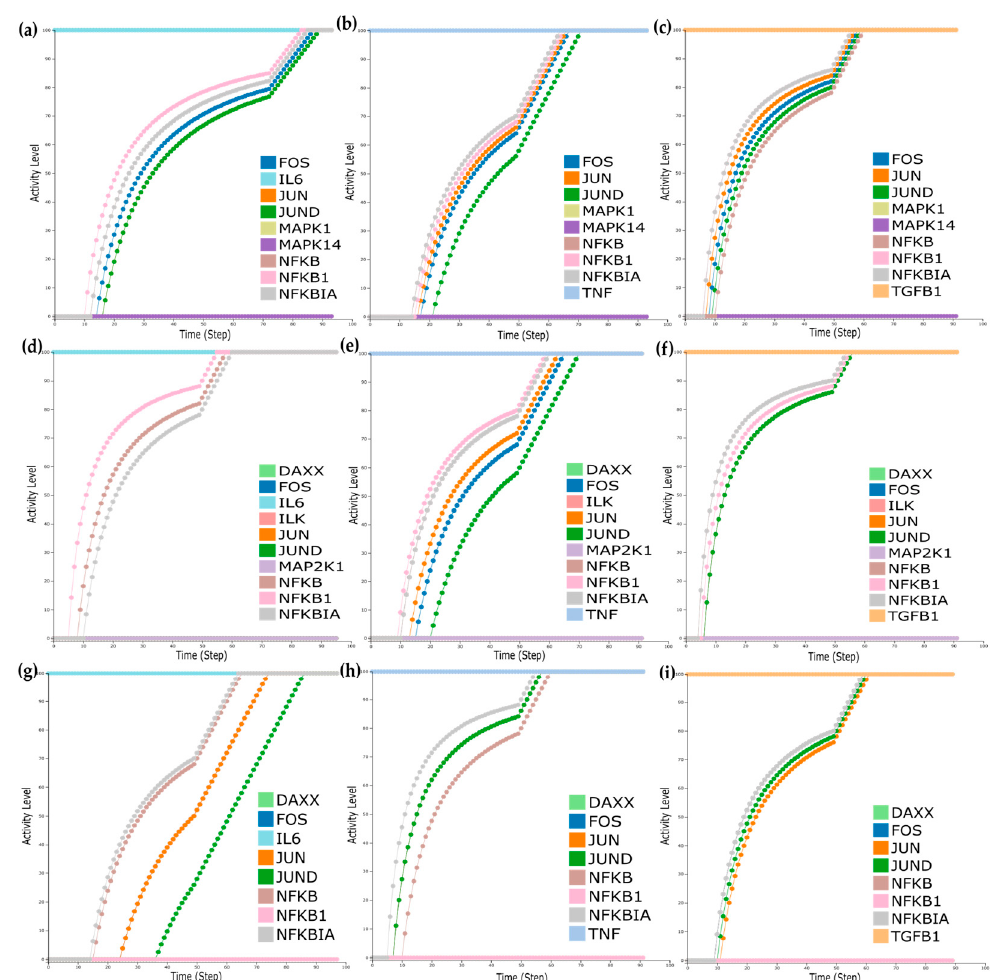
Figure 6. Real-time simulations with Cell Collective for the dataset of before and after anti-TNF treatment of RA patients, where MAPK14 and MAPK1 were found to be downregulated ( a – c ); ( a ) simulations with IL6 activity set to 100%, ( b ) simulations with TNF activity set to 100%, ( c ) simulations with TGFB1 activity set to 100%. Real-time simulations for the dataset of responders/non-responders where MAP2K1, ILK, and DAXX were found downregulated ( d – f ); ( d ) simulations with IL6 activity set to 100%, ( e ) simulations with TNF activity set to 100%, ( f ) simulations with TGFB1 activity set to 100%. Real-time simulations for the dataset of the mutation carrier. ( g – i ); ( g ) simulations with IL6 activity set to 100%, ( h ) simulations with TNF activity set to 100%, ( i ) simulations with TGFB1 activity set to